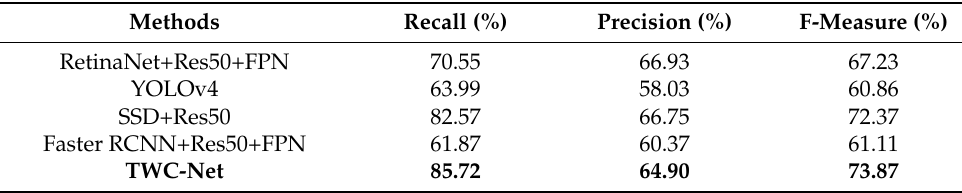
Table 6. Recall, precision, and F-measure of all